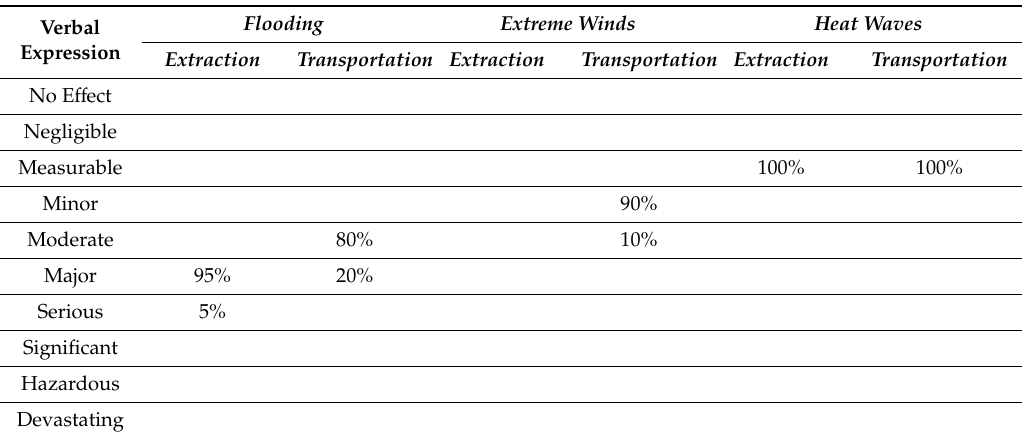
Table 6. Expected losses as a percentage of annual turnover for CLIRMI mine (per